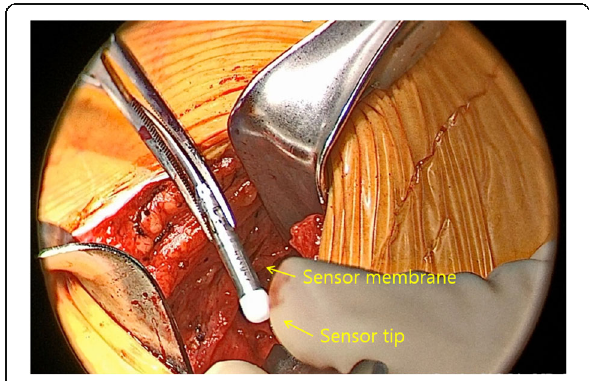
Fig. 2 Pleural pressure sensing lead is placed with the ventilatory sensor facing the pleura